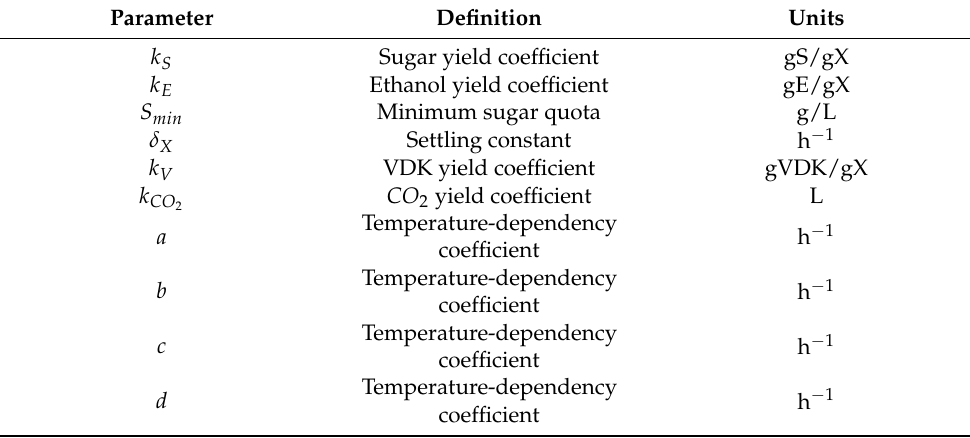
Table A1. Parameter nomenclature list for biomass